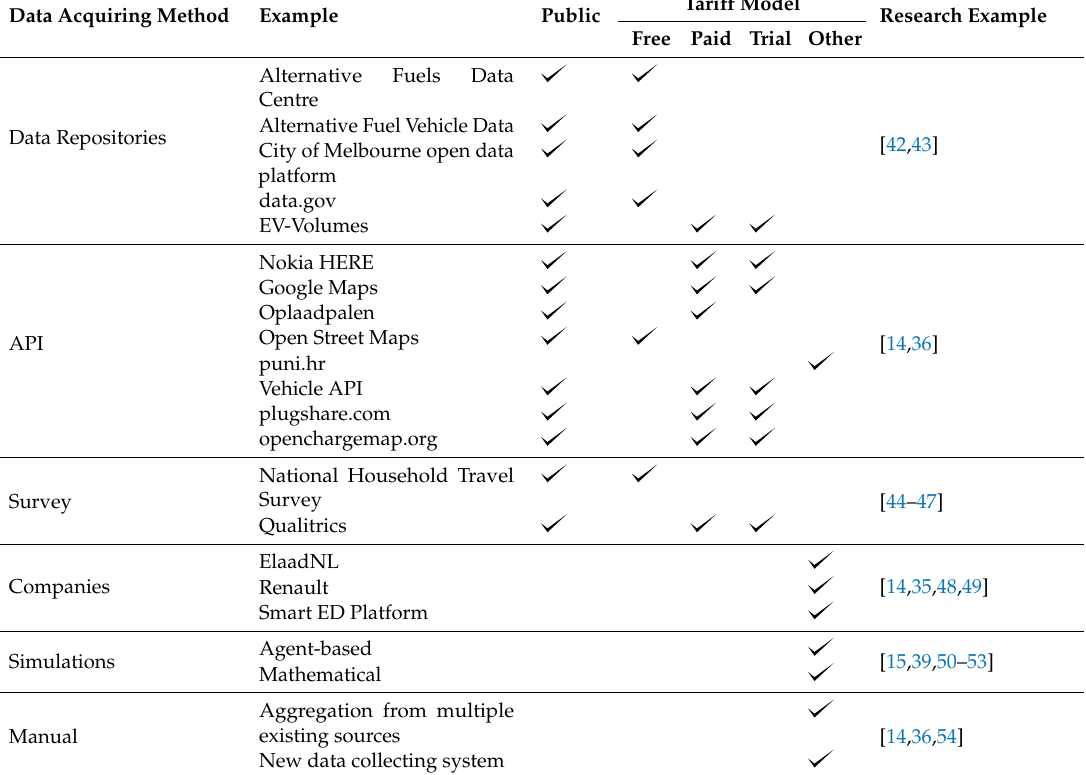
Table 1. Data gathering methodology with examples and tariff model for each data